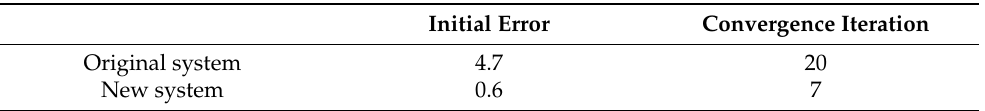
Table 2. Effect of Translational Experience Transform.